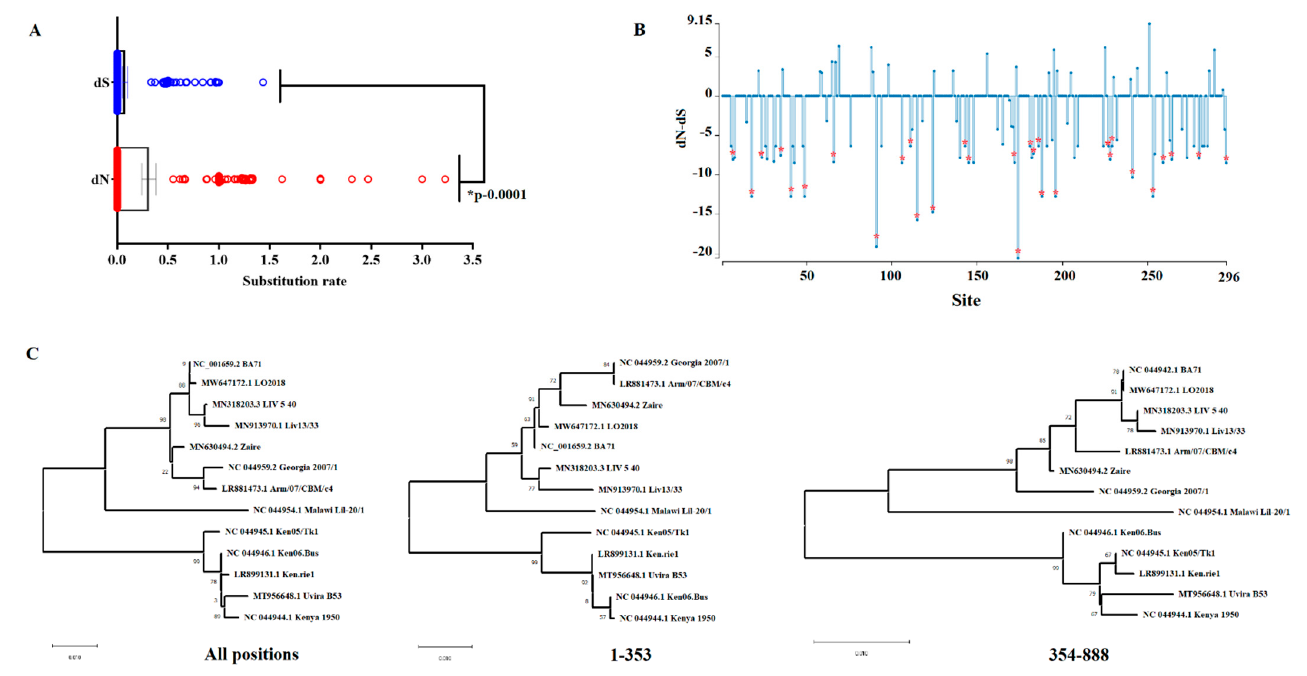
Figure 2. Evolutionary signatures of EP296R gene of ASFV. ( A ) Comparison between synonymous (dS) and nonsynonymous (dN) substitution rates during the evolution of EP296R gene. Significant differences between means at dS and dN were determined by the unpaired t -test. Analysis was conducted on the software Jalview version 2.11.1.7. ( B ) Graphic representation of the ratio dN-dS at specific codon sites in the EP296R gene of ASFV. Red asterisks represent codon sites evolving under purifying selection. Analysis was conducted using the evolutionary algorithms FEL considering a cutoff value of p = 0.1. ( C ) Phylogenetic analyses using different segments (all sites, 1–353 and 354–888) of the EP296R gene of ASFV were conducted by the neighbor-joining method and the p -distance model to show the topology incongruency produced by the recombinant breakpoint predicted by GARD at nucleotide 353. Numbers above internal branches represent bootstrap values (1000 repetitions). Phylogenetic analysis was conducted using the software MEGA 10.2.5.